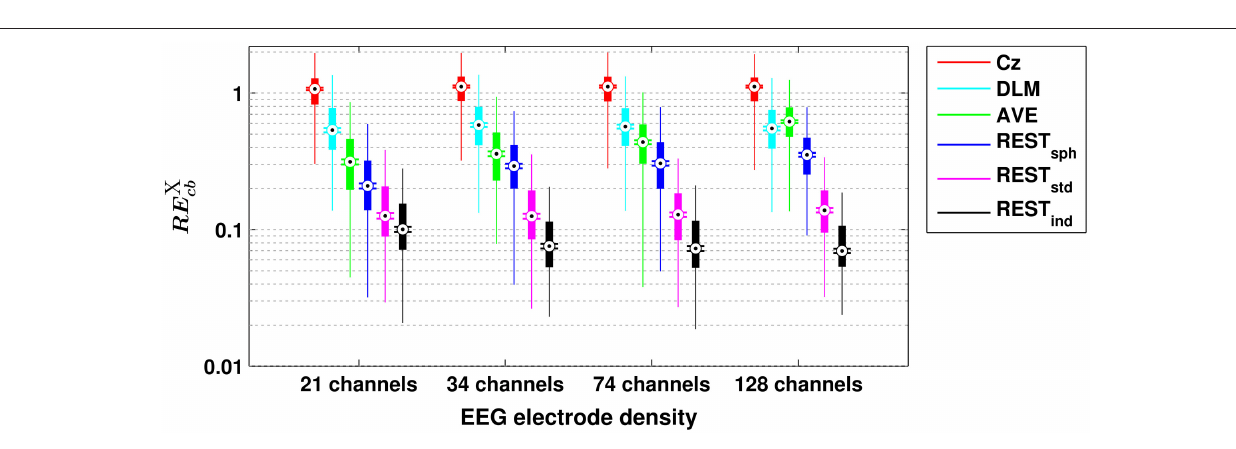
FIGURE 2 | Box plots for the relative error for cross-bicoherence ( RE X cb ) evaluated with different EEG reference schemes and with different EEG electrode densities. The ordinate axis is logarithmically scaled. Each box plot displays the RE-values from 1,000 simulation